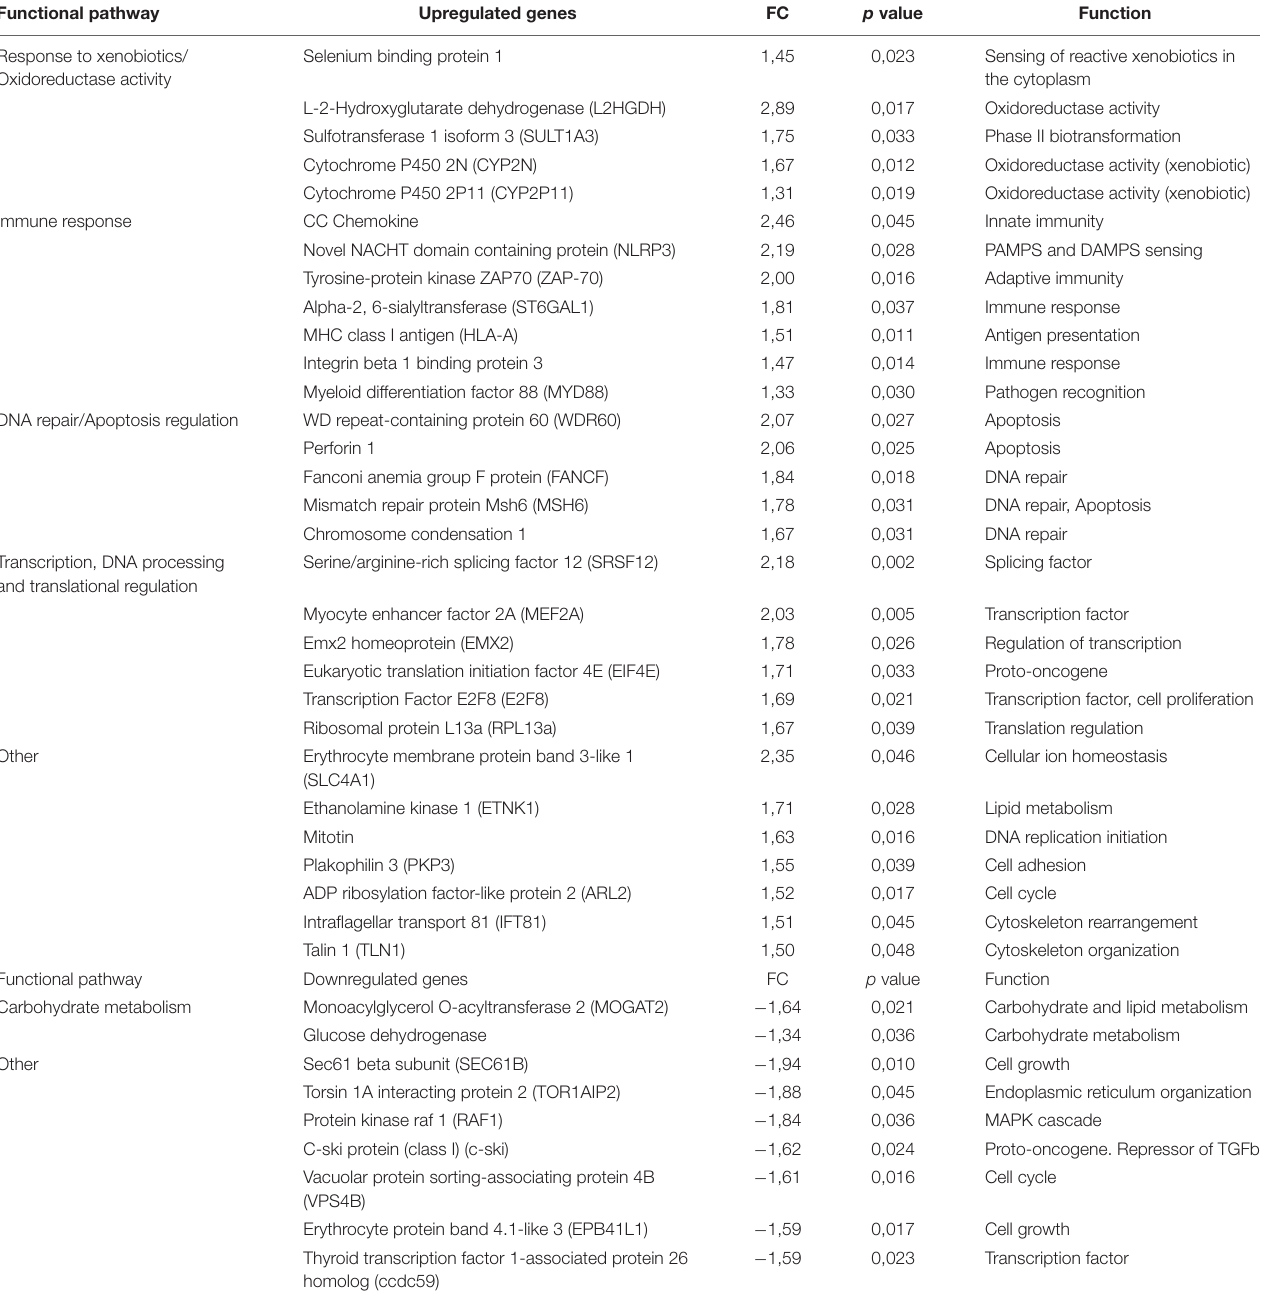
TABLE 1 | Differentially expressed genes for 0.5 µ g/L